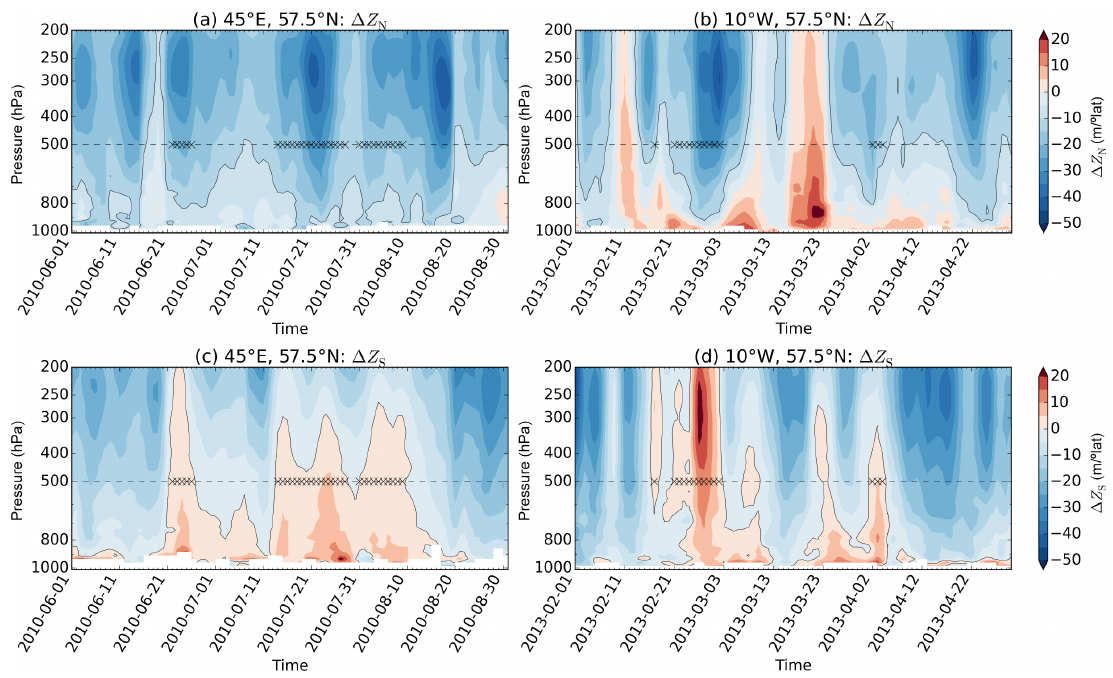
Figure 5. Temporal evolution of (cid:49)Z N and (cid:49)Z S during the (a, c) Russian and (b, d) Greenland blocking. Blocking criteria (solid black contours) are indicated at − 10m/ ◦ lat for (cid:49)Z N and 0m/ ◦ lat for (cid:49)Z S . IB (crosses) is indicated at the 500hPa pressure level (dashed black line).